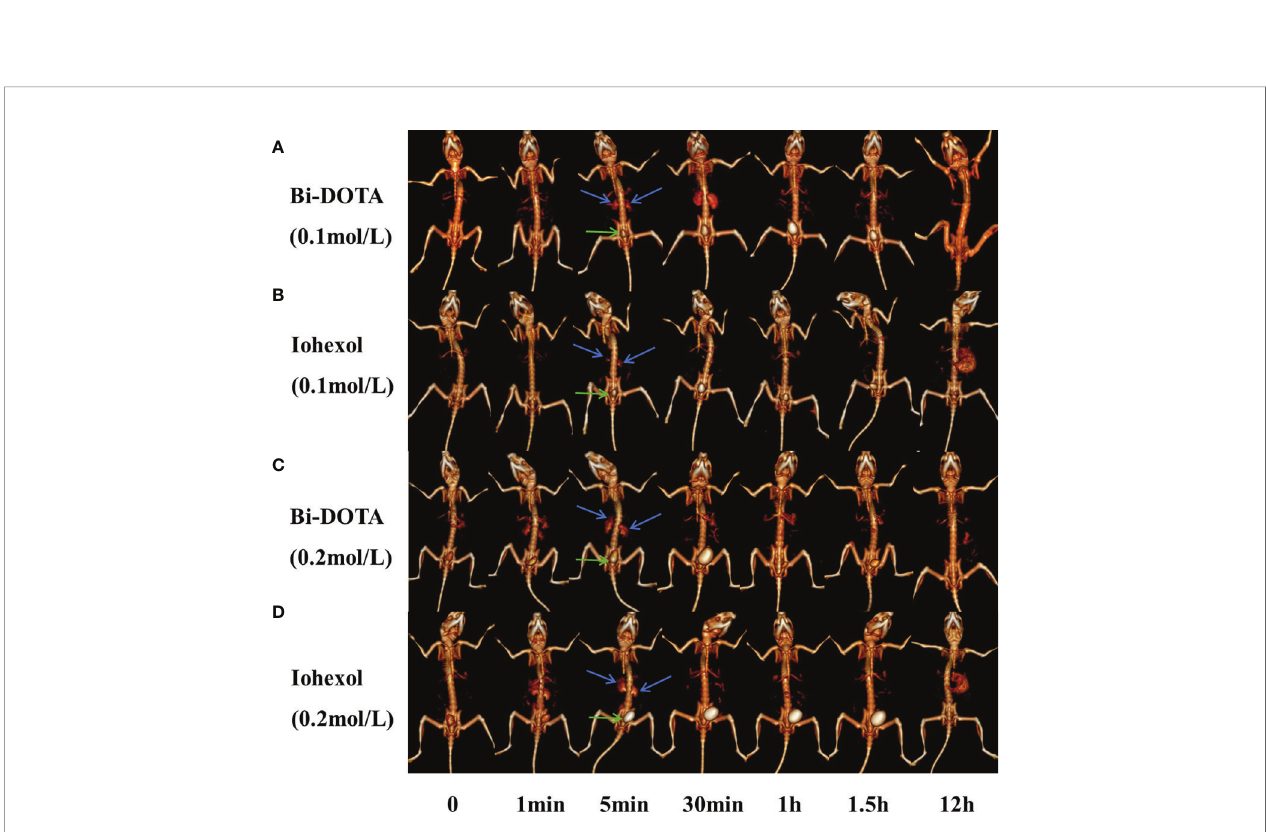
FIGURE 4 | In vivo CT urography imaging using Bi-DOTA and iohexol (blue arrows represent kidney and green arrows represent bladder). CT imaging after intravenous administration of (A) 0.1 mol/L Bi-DOTA, (B) 0.1 mol/L iohexol, (C) 0.2 mol/L Bi-DOTA, and (D) 0.2 mol/L iohexol.